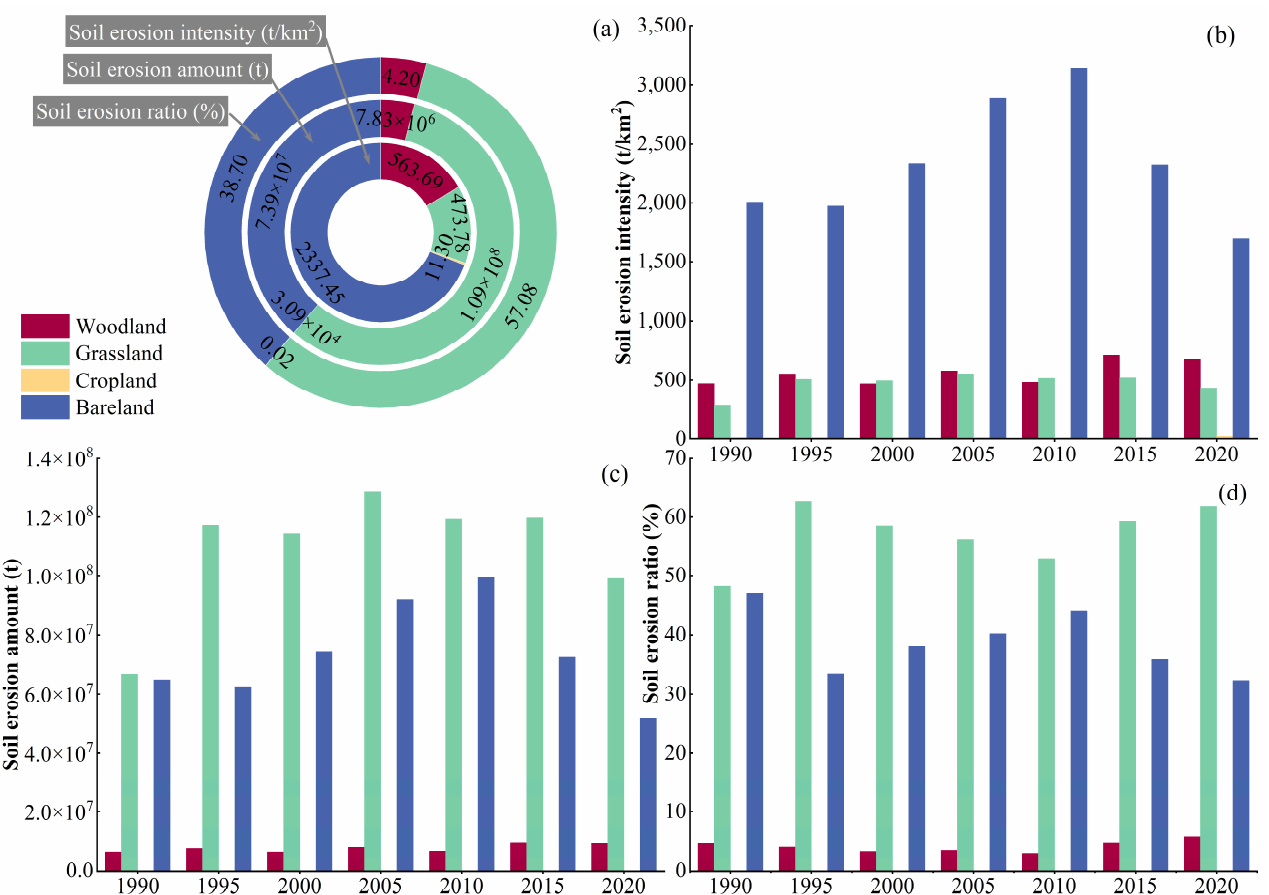
Figure 8. SE characteristics of LU types in the QLB. The average value of SEI for many years ( a ); the SEI from 1990 to 2020 ( b ); the SEA from 1990 to 2020 ( c ); the SER from 1990 to 2020 ( d ). Table 7. SEI, SEA, and SER at different